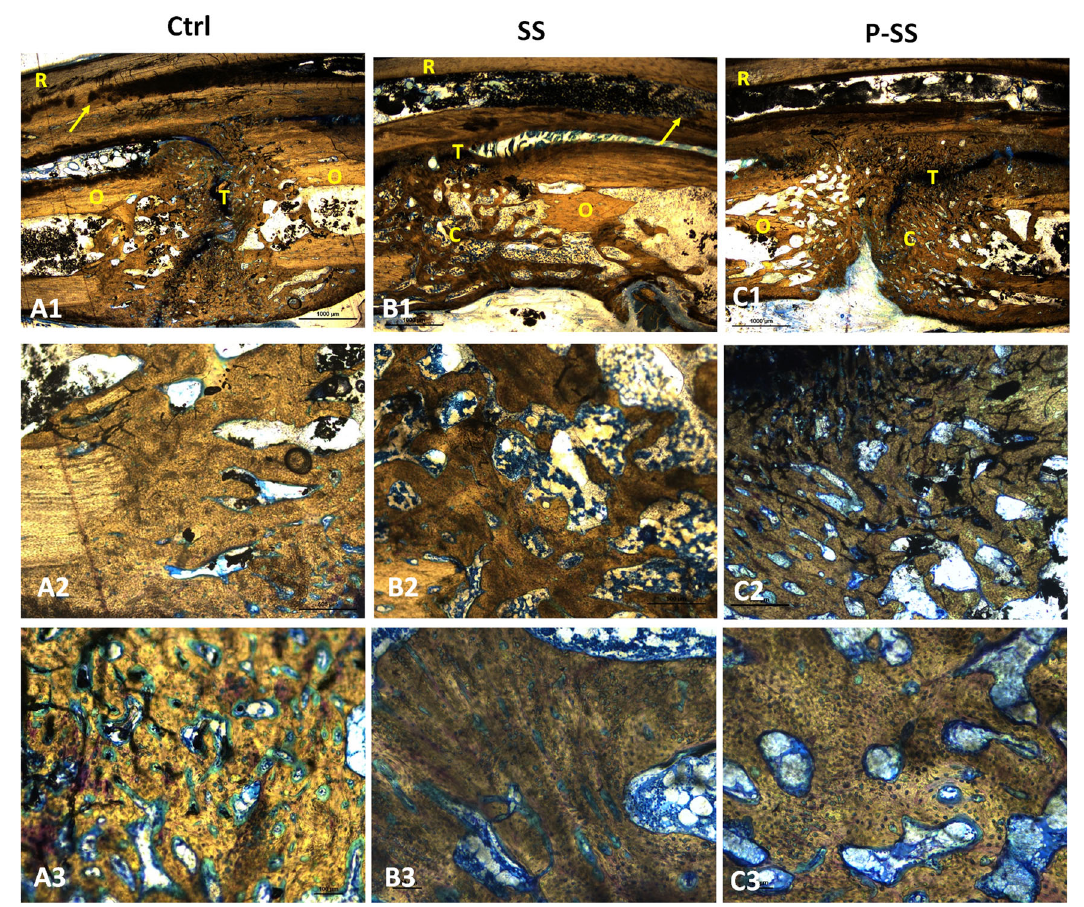
Fig. 7 Histology analysis by Stevenel ’ s blue and van Gieson ’ s picrofuchsin stains after 12 weeks on ( A ) control; ( B ) SS and ( C ) P- SS, ( A1 , B1 & C1 ) showing the interface between old and newly formed bone (Scale bar: 1000 µm); ( A2 , B2 & C2 ) represents features